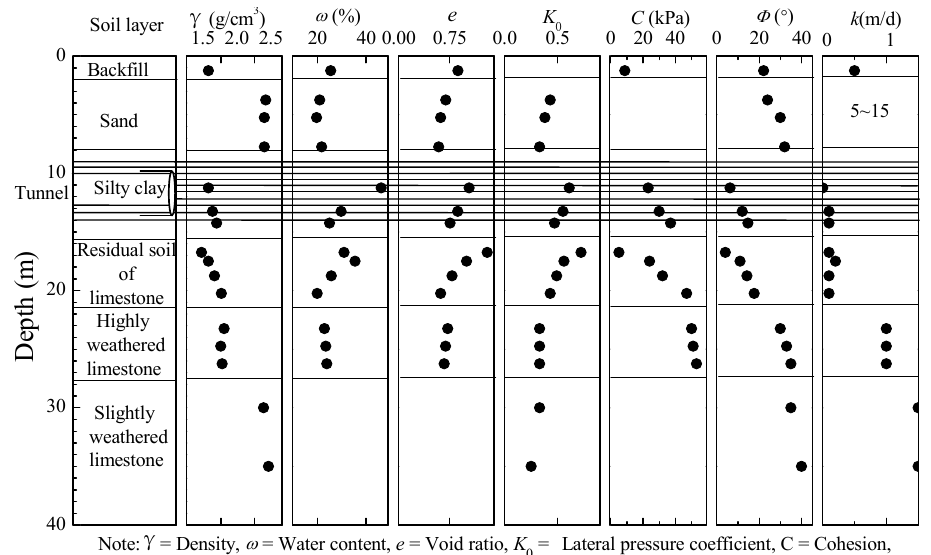
Figure 4. Geotechnical profiles of the construction site.